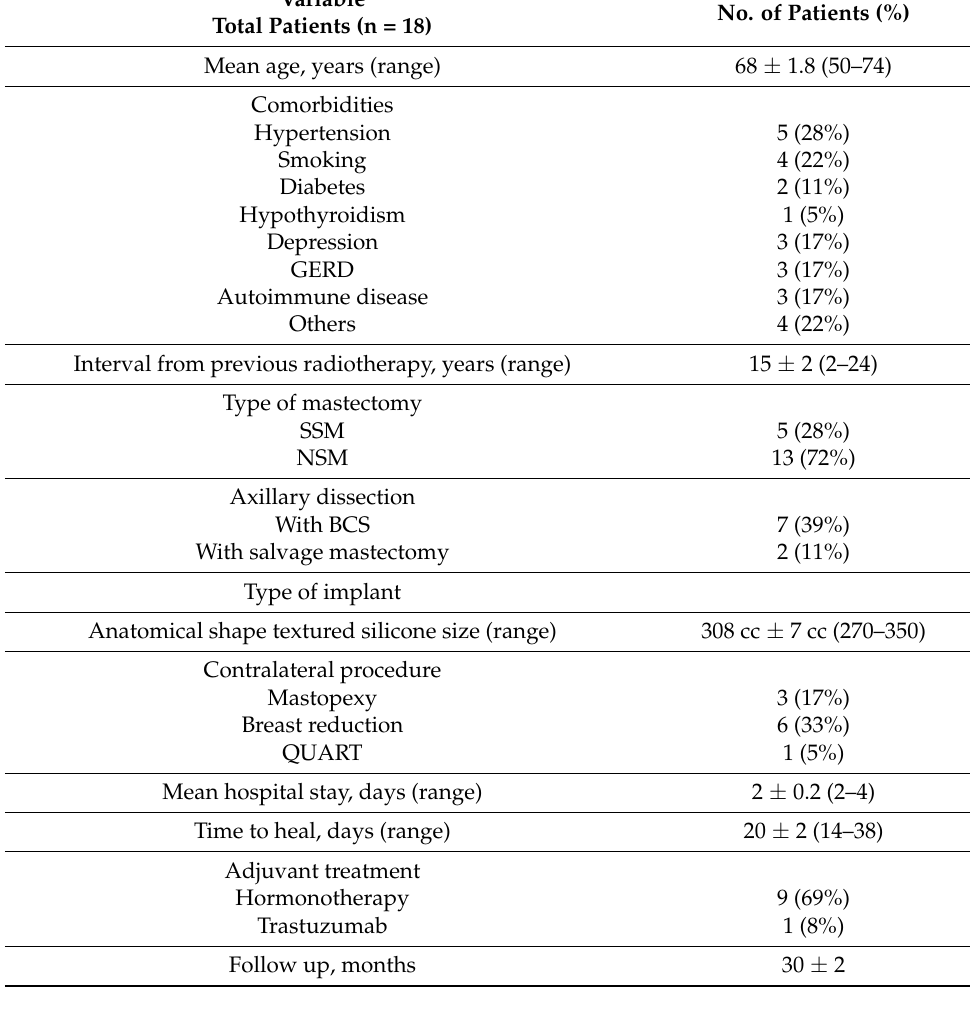
Table 1. Patient demographics. BCS: breast conserving surgery, GERD: gastroesophageal reflux disease, NSM: nipple-sparing mastectomy, QUART: quadrantectomy + radiotherapy, SSM: skin- sparing mastectomy.